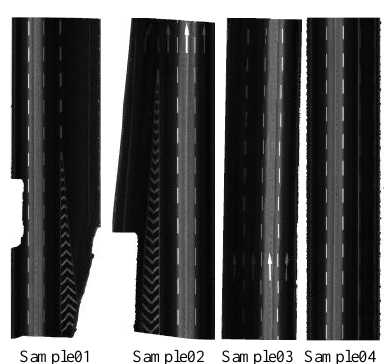
Figure 8. Intensity image of sample area